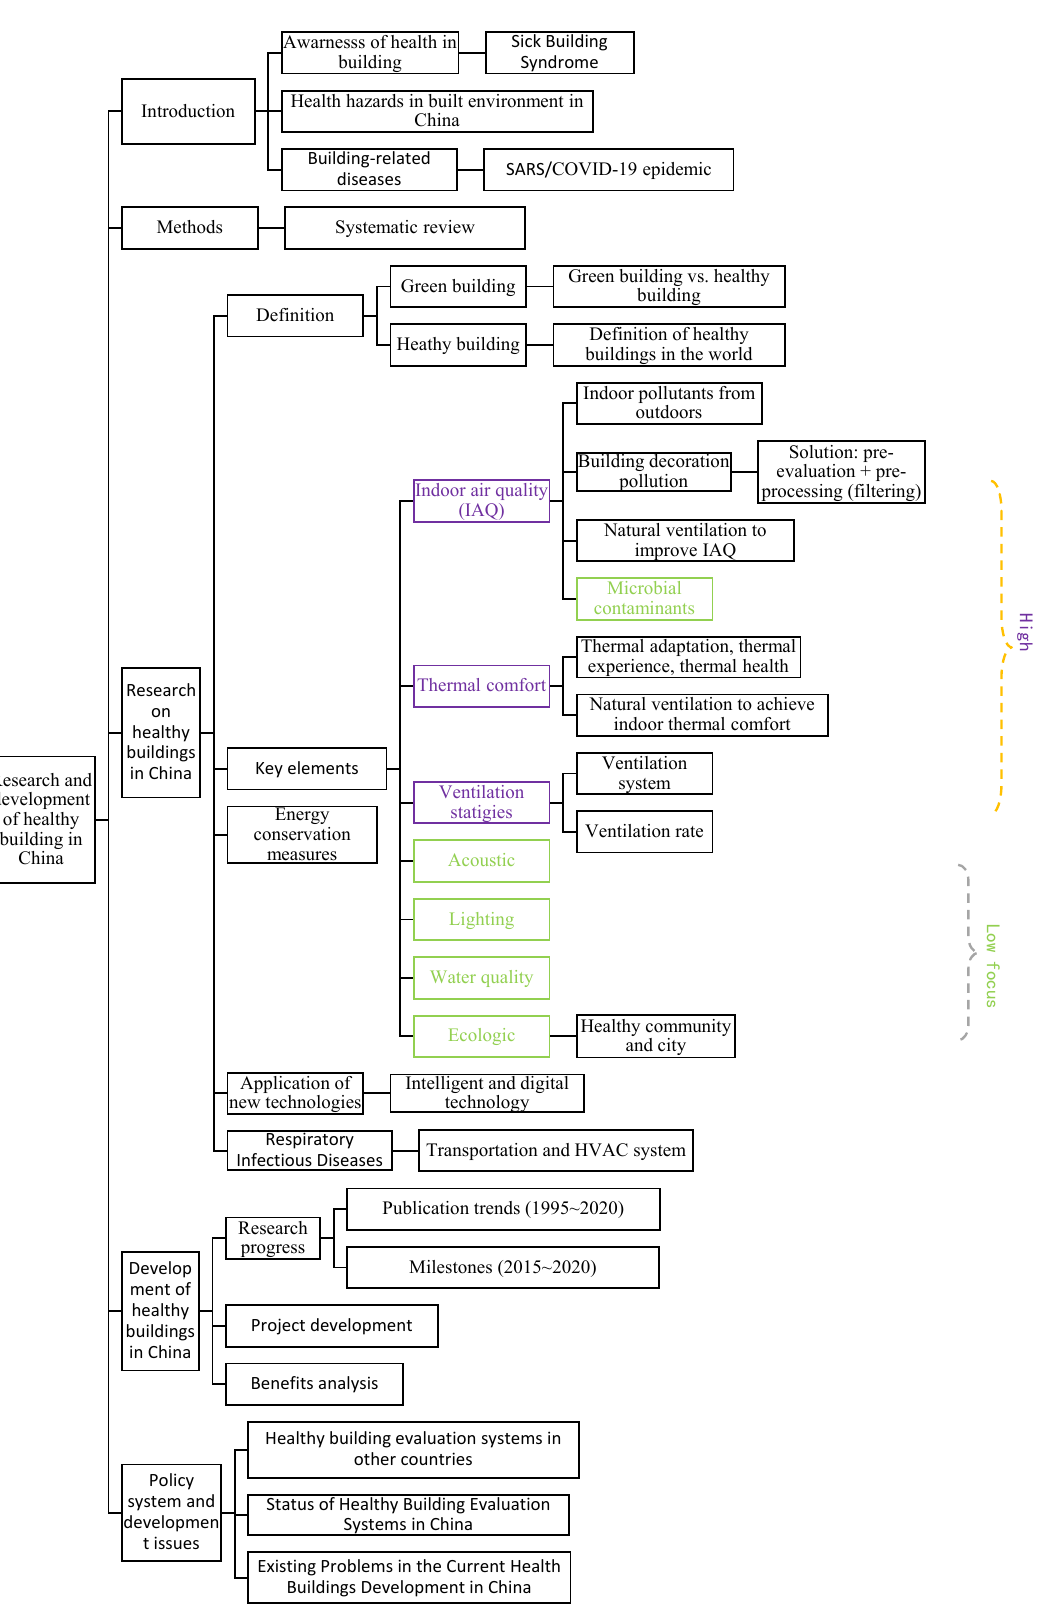
Figure 1. Structure of the paper.